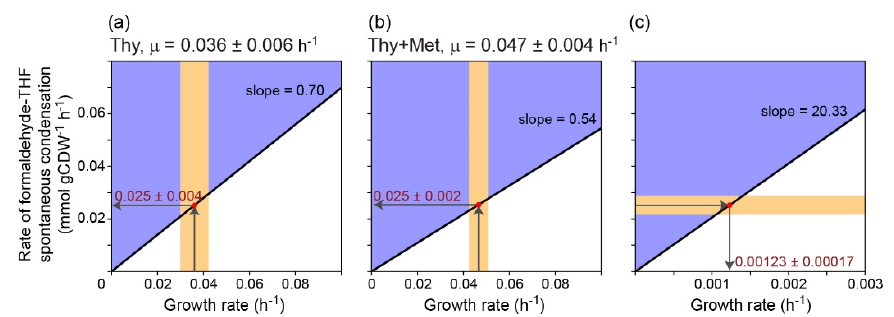
Figure 4. Computational modeling of the relationship between the growth rate and the rate of the spontaneous condensation of formaldehyde and THF. Shown are the phenotypic phase planes of the formaldehyde condensation reaction, when ( a ) thymidine (Thy) is added to the medium; or when ( b ) thymidine and methionine (Thy + Met) are added to the medium. ( c ) Phenotypic phase plane of the formaldehyde condensation reaction when this reaction provides the sole source of carbon via the serine cycle.